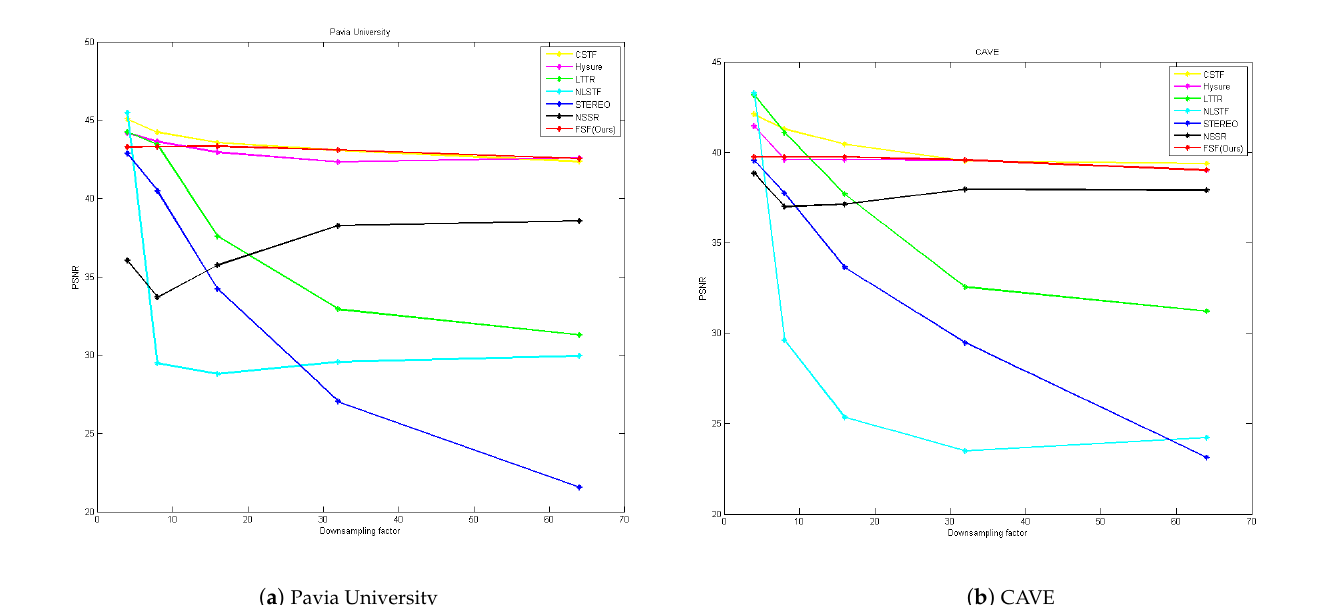
Figure 6. Comparison of the fusion results of the methods with different downsampling